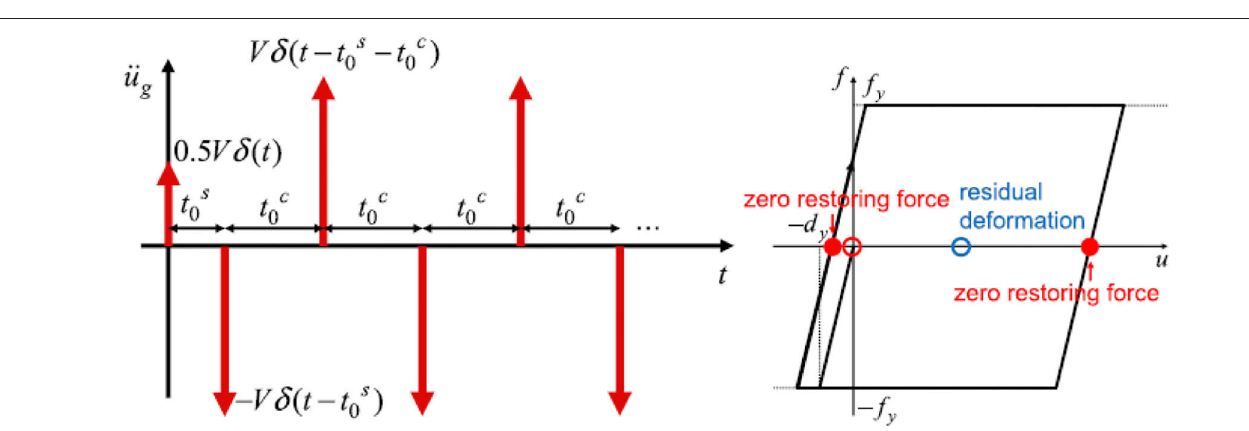
Frontiers in Built Environment |